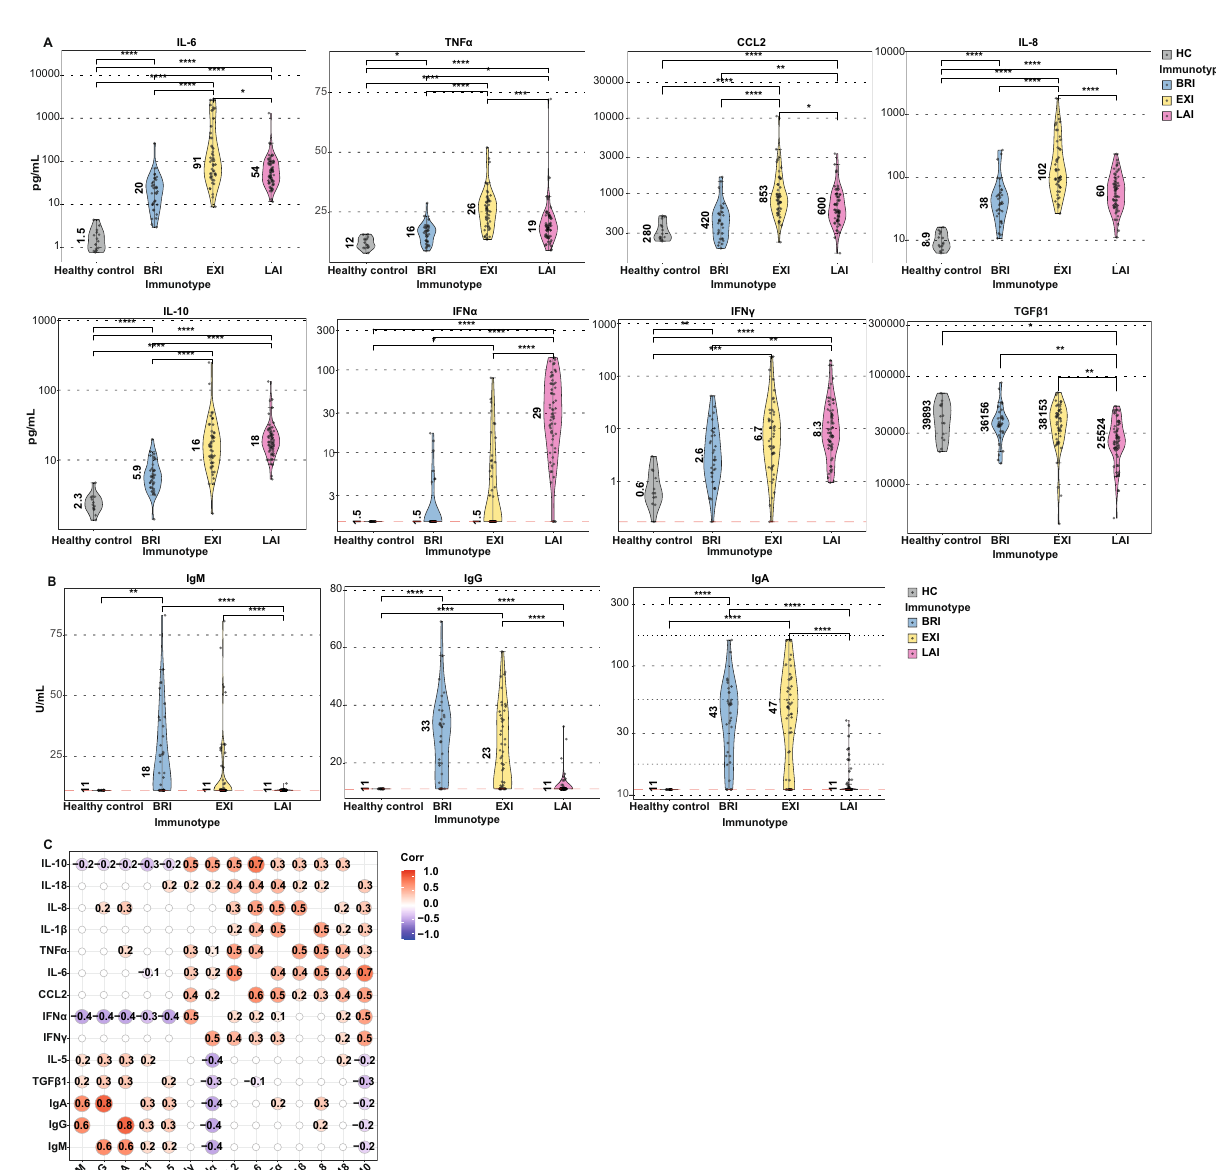
IgMIgGIgATGFβ1IL-5IFNγIFNαCCL2IL-6TNFαIL-1βIL-8IL-18IL-10 Fig. 2 COVID-19 immunotypes have distinct cytokine and anti-SARS-CoV-2 antibody levels. Immunotypes BRI, EXI and LAI have distinct patterns of cytokines and anti-SARS-CoV-2 antibodies. A Serum cytokines and B IgM, IgG, and IgA anti-SARS-CoV-2 antibodies are shown for BRI ( n = 33), EXI ( n = 46) and LAI patients ( n = 59) and healthy controls ( n = 14). Violin plots with single data points depict the range of levels and number indicates medians. Whiskers indicate the 1.5x interquartile range (IQR) value. A two-sided Wilcoxon rank-sum statistical test with Bonferroni correction was applied on all six comparisons but only shown for signi fi cant differences. Red dashed line indicates lower limit of detection. C Correlograms depicting correlations between cytokines and antibodies ( n = 138 patients). Red indicates positive and blue negative correlation. Only statistically signi fi cant association ( p < 0.05) are shown. Spearman ’ s rho ( R s ) is shown in circles. * p < 0.05, ** p < 0.01, *** p < 0.001, and **** p < 0.0001. Deep phenotyping of immunotypes reveals distinct cellular levels of markers of in fl ammation C-reactive protein (CRP), changes in blood of COVID-19 patients . To acquire insight into ferritin, d-dimer, Lactate dehydrogenase (LDH) were all sig- ni fi cantly higher in EXI (Fig. 5A). Strikingly, these were not the potential mechanisms that are behind the described three increased in LAI compared to BRI. Leukocytes and neutrophils immunotypes we used 40-color spectral fl ow cytometry and iden- were highest in EXI, while lymphocyte levels trended to be lower ti fi ed the immune cell subset changes associated with these in EXI and LAI but were not signi fi cant (Fig. 5B). Thrombocytes, immunotypes (Fig. 6). Although COVID-19 patients as a whole however, were signi fi cantly lower in LAI patients (Fig. 5B and differed clearly from healthy individuals, comparing immunotypes Table 2). Viral loads in nasopharyngeal swabs were not sig- at study entry found remarkably few differences between them. ni fi cantly different between immunotypes but trended to be COVID-19 patients compared to healthy individuals had increased higher in LAI (Fig. 5C), while within LAI patients, viral loads did plasmablasts (Fig. 6B – D and Supplementary Table S2). The pro- not correlate with IFN α levels (Fig. 5D). Finally, we found no in fl ammatory intermediate monocytes 1 and 2 10 and pro- in fl ammatory IgD-negative non-conventional memory B cells correlation between viral load and DFSO (Rs = – 0.18, p = 0.34). NATURE COMMUNICATIONS| (2022) 13:915